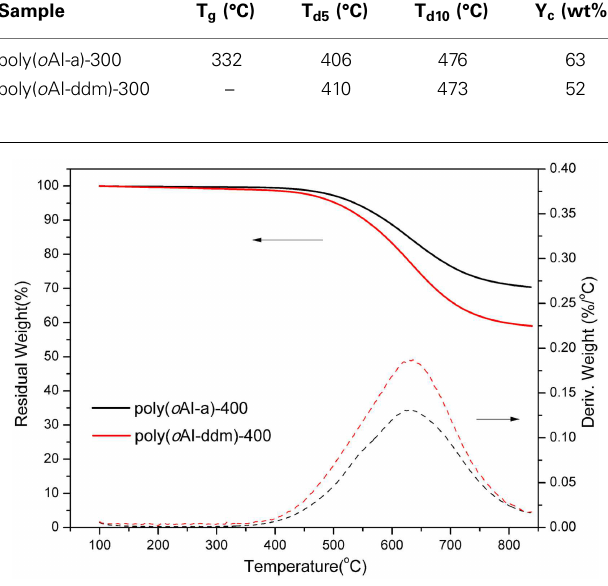
FIGURE 13 |Thermogravimetric analysis of poly( o AI-a)-400 and poly( o AI-ddm)-400 .